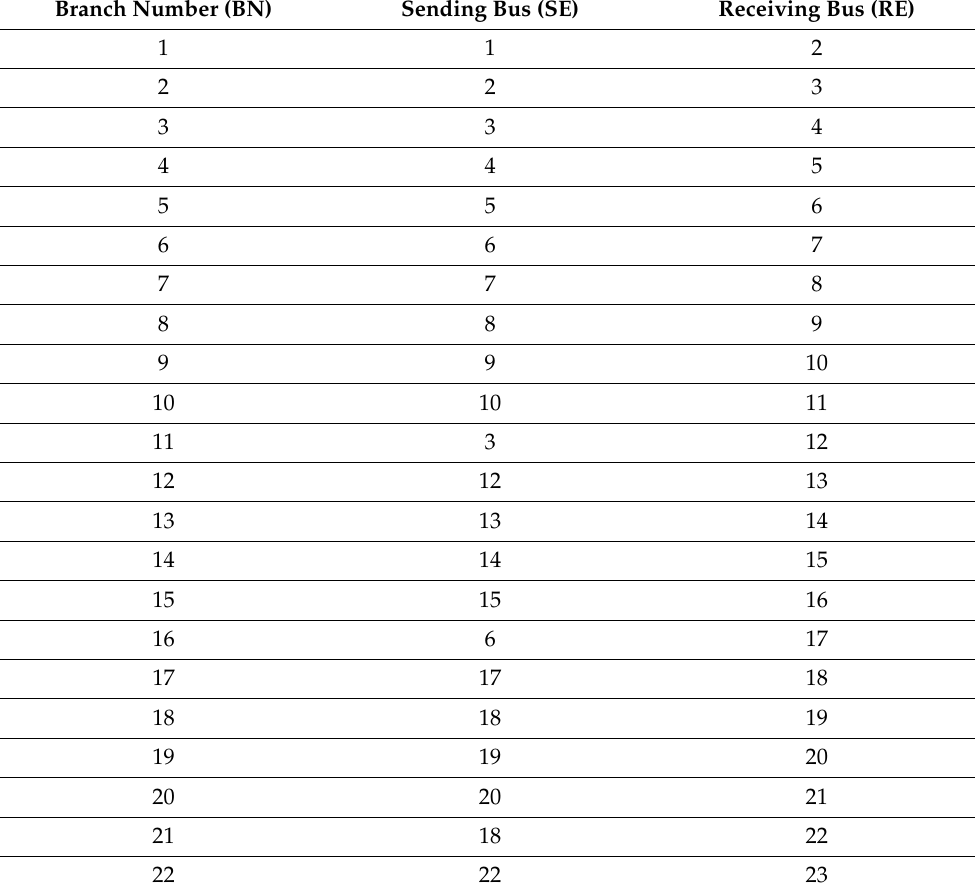
Table 3. Branch numbering of the distribution network in Figure 3. Branch Number(BN)